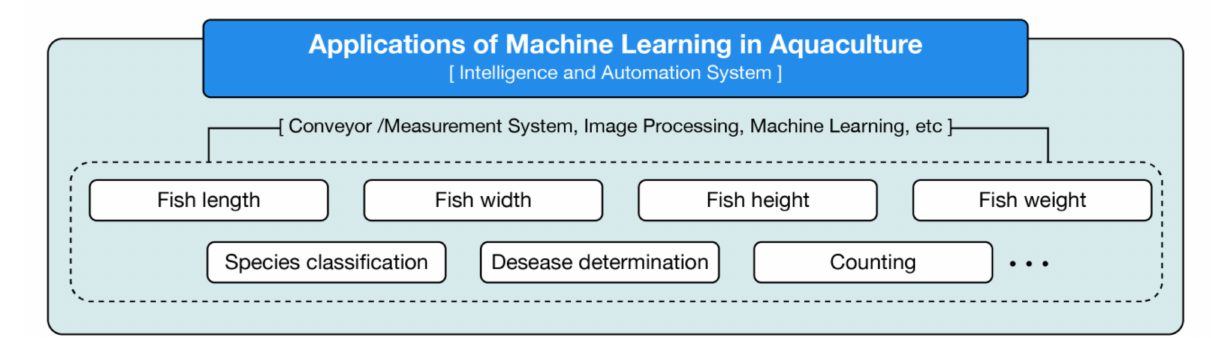
Figure 8. Overview of application of machine learning in aquaculture systems.